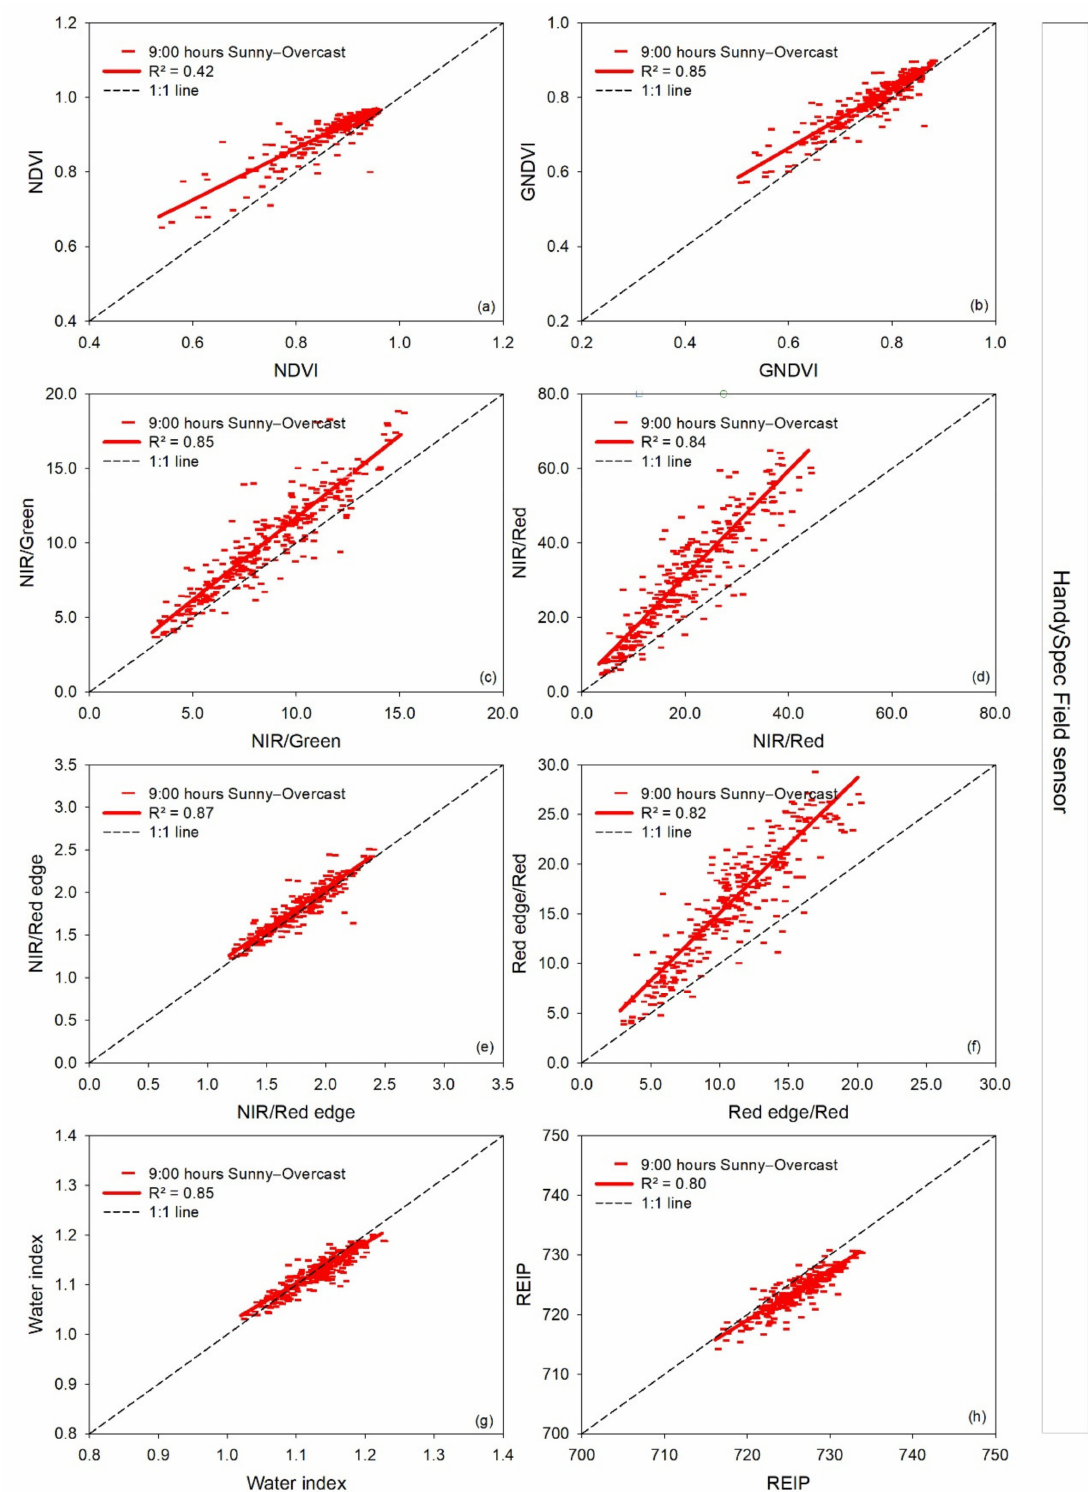
Figure 8. Linear regressions between paired measurement times at 9:00 h in a sunny (independent variable) (08-05-2019) and overcast (dependent variable) (07-05-2019) day of each vegetation index measured with the handheld hyperspectral bidirectional HandySpec Field sensor. R 2 : coefficient of determination. The dashed line represents the 1:1 line. In the pairwise comparison, the sunny day’s information is indicated on the x-axis and for the overcast day on the y-axis ( a – h